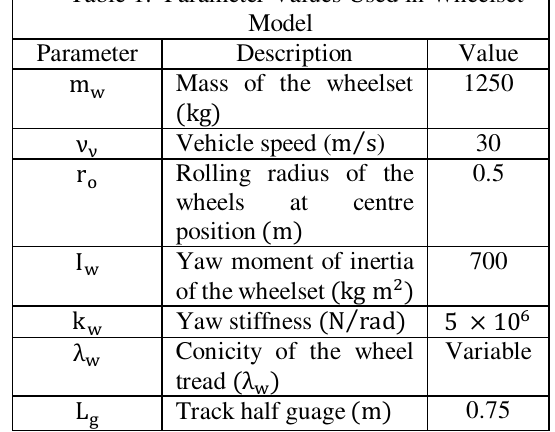
Table 1: Parameter Values Used in Wheelset Model